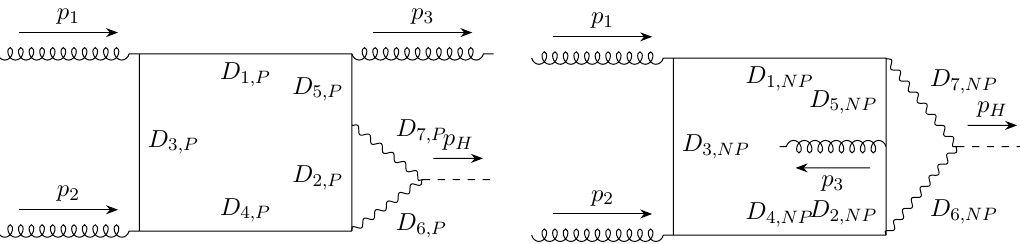
Figure 1 . The scalar top-topologies associated to the propagator sets in table 2. Continuous lines denote massless propagators, wavy lines denote massive propagators. All external particles are